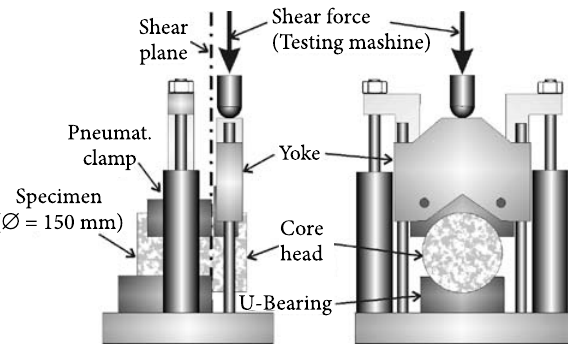
fig. 1. LPDS test device, schematic drawing (Raab, Partl 2004)